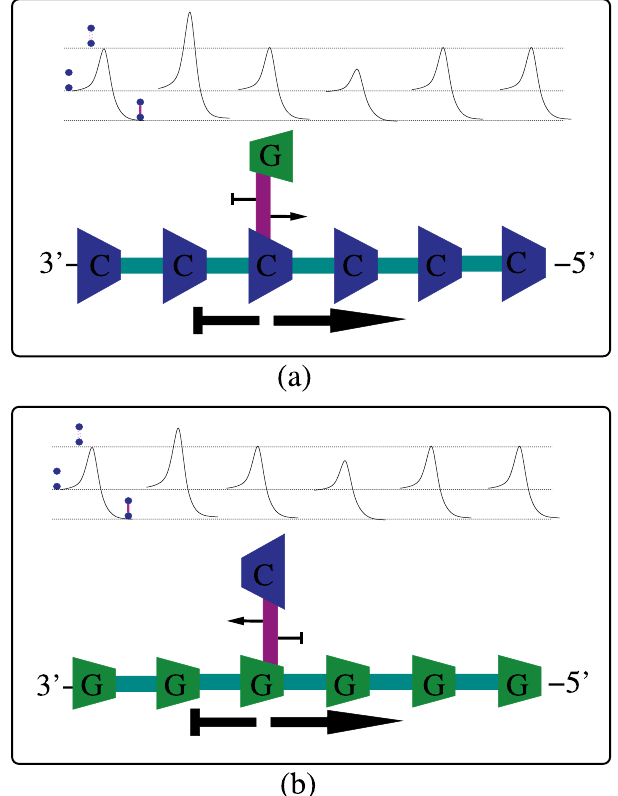
Figure 2. Illustration of sequence-independent asymmetric cooperativity in DNA single strands. The asymmetric cooperativity mode of a single template strand is dictated by the 3 ′ –5 ′ directionality of the strand. ( a ) A hydrogen bond between a lone nucleotide G and the template strand catalyzes the formation of another hydrogen bond to its right by reducing its kinetic barrier, while inhibiting the formation of its left neighbor by raising its barrier. The strength and the mode of sequence-independent asymmetric cooperativity dictated by the template strand is denoted by the thick black arrow below the template strand, pointing to the right. The thin arrows attached to the hydrogen bond denote the weaker sequence-dependent asymmetric cooperativity strength and mode. ( b ) Irrespective of the type of nucleotides occupying the template strand, the directionality of the template strand alone dictates the mode of sequence-independent asymmetric cooperativity. The thinner arrows on the hydrogen bond, denoting sequence-dependent part, though pointing in the opposite direction, does not alter the overall mode of asymmetric cooperativity due to the relative strength of sequence- independent part. This can be seen in the kinetic barrier diagrams above the bonds, where the barrier on the right of the hydrogen bond is lower in both ( a , b ), and the barrier on the left is higher. This assumption ensures that the daughter strand is always constructed from the 5 ′ end of the daughter strand to its 3 ′